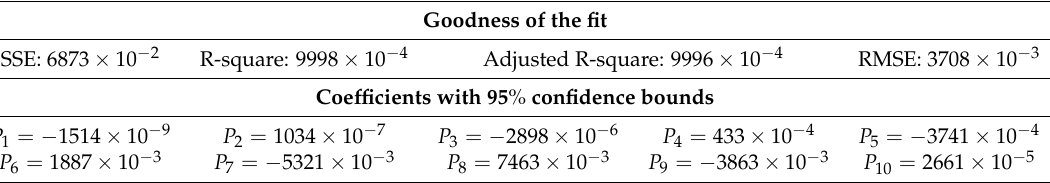
Table 2. Goodness and coefficient parameters of the fitting